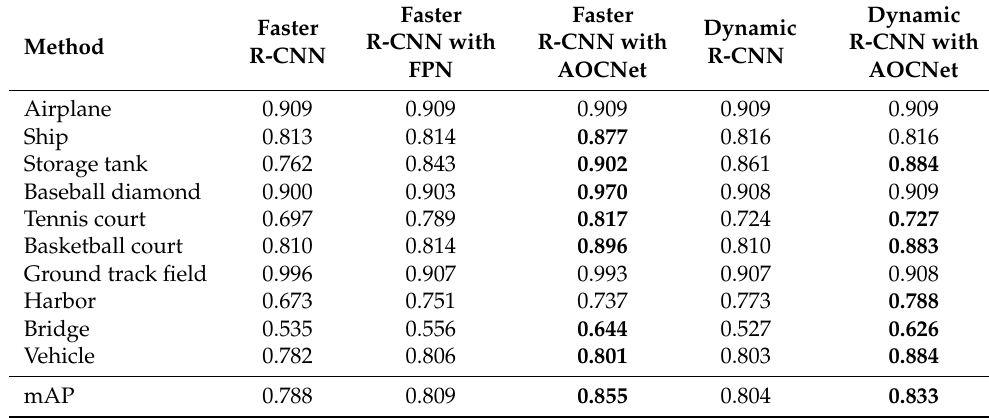
Table 3. The comparative experiments of different methods on the NWPU VHR-10